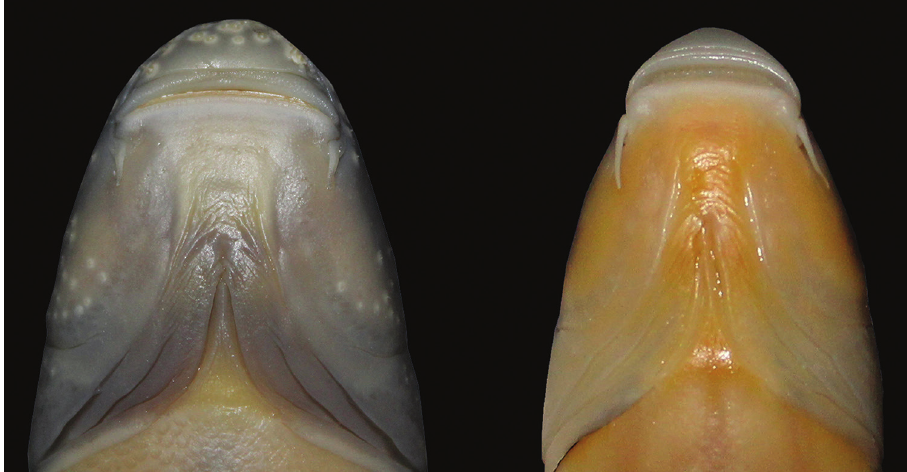
Figure 5. Ventral view of Head. Capoeta razii sp. n. (right, IMNRF-UT-1072-11, SL: 109 mm) and C. capoeta (left, IMNRF-UT-1067-6, SL: 110